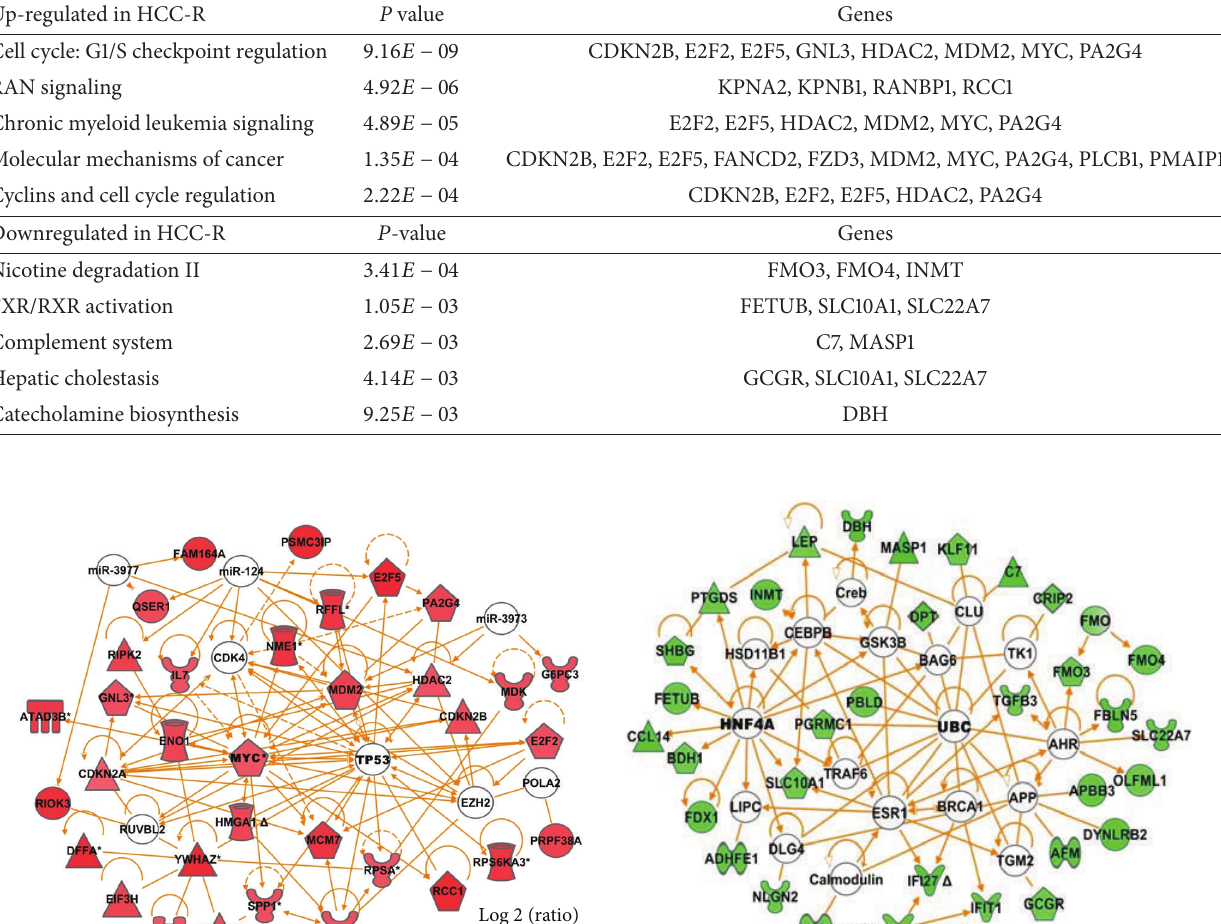
Table 2: Top canonical pathways: significant molecular pathways regulated in HCC-R.